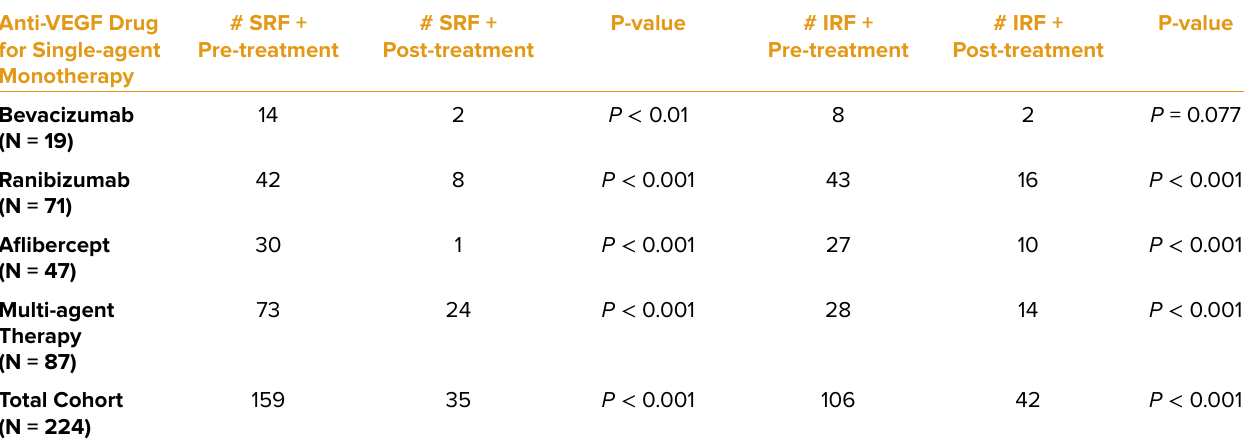
Table 2. OCT* characteristics of single-agent vs multi-agent anti-VEGF therapy Anti-VEGF Drug